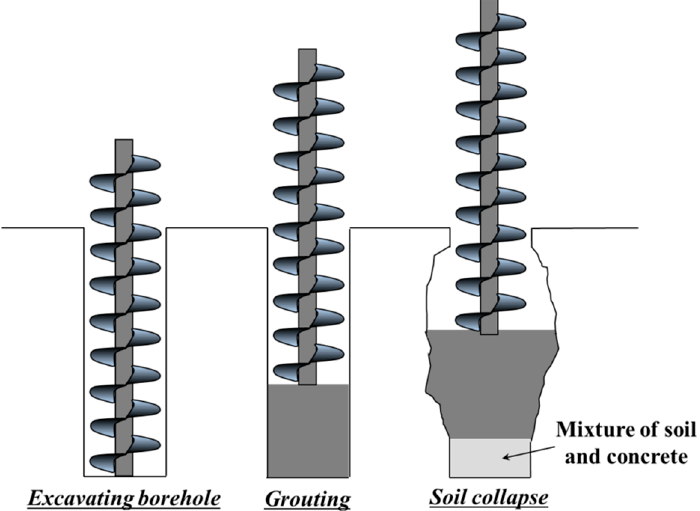
Figure 1. Soil collapsing effect in CFA pile.